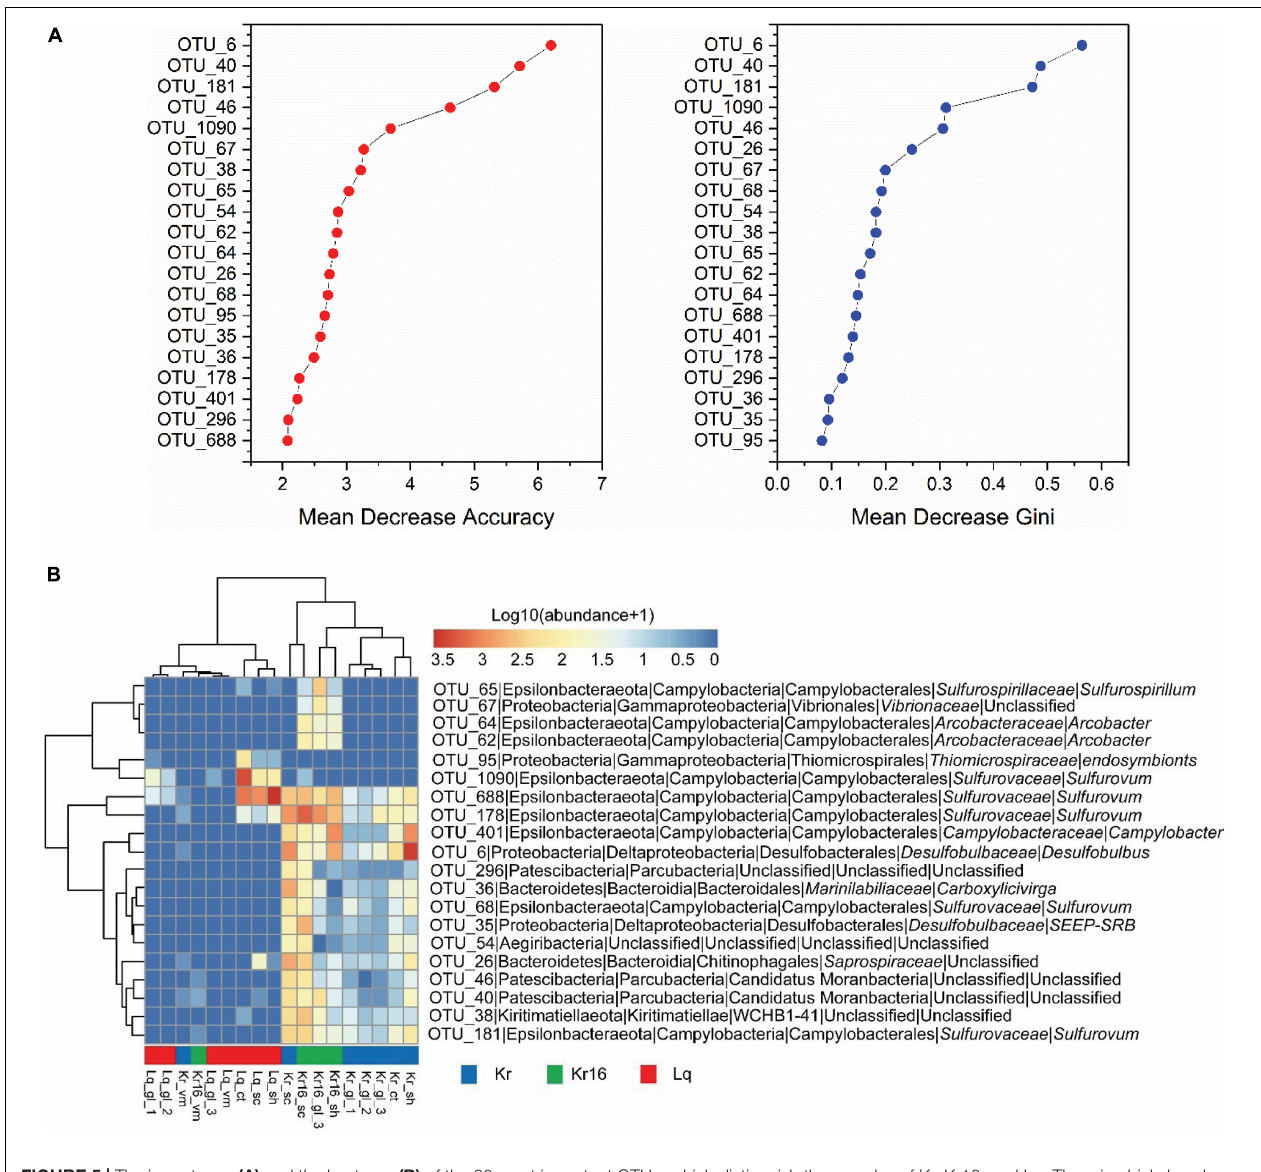
FIGURE 5 | The importance (A) and the heatmap (B) of the 20 most important OTUs, which distinguish the samples of Kr, Kr16, and Lq. The microbial abundance was scaled with log transformation in the heatmap. Kr refers to SFS samples collected from the Kairei vent field; Kr16 refers to SFS samples collected from the Kairei vent field, and reared for 16 days; Lq refers to SFS samples collected from the Longqi vent